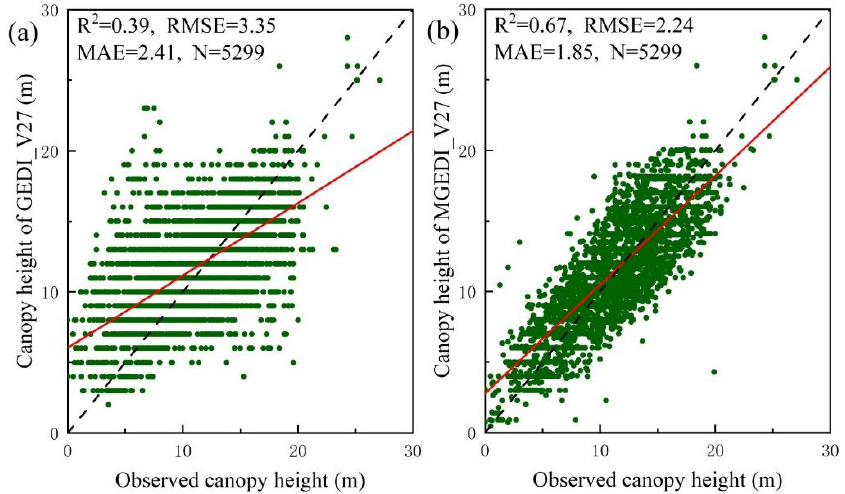
Figure 13. Accuracy assessment results of two canopy height models. ( a ) Linear regression of canopy height between the GEDI_V27 and the sample set. ( b ) Linear regression of canopy height between the MGEDI_V27 and the sample set. The dotted line represents a 1:1 match, and the red line represents the trend of the forest canopy height relationship between the field measurements and the two products.